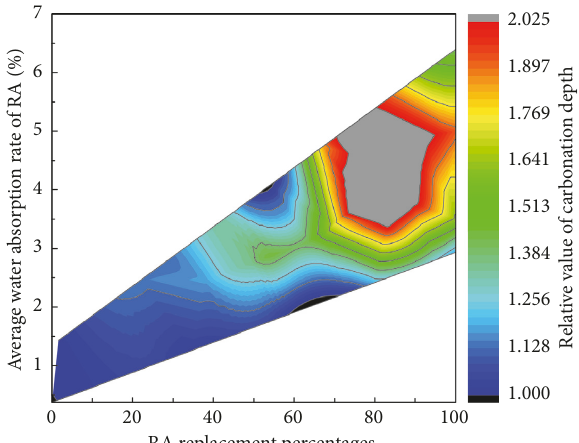
Figure 8: Correlation between the relative carbonation depth of RAC, the average water absorption rate, and replacement percentages of RA.